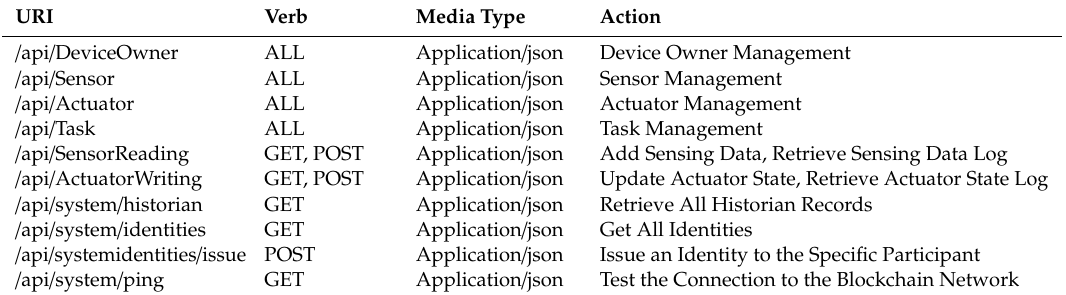
Table 7. RESTful API used for interaction.